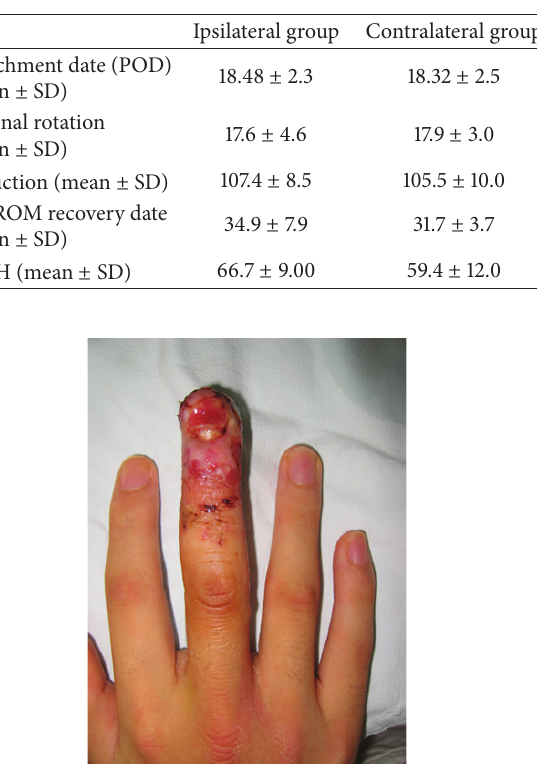
Figure 3: After 18 days of abdominal pocketing, the finger shown in Figure 1 survived